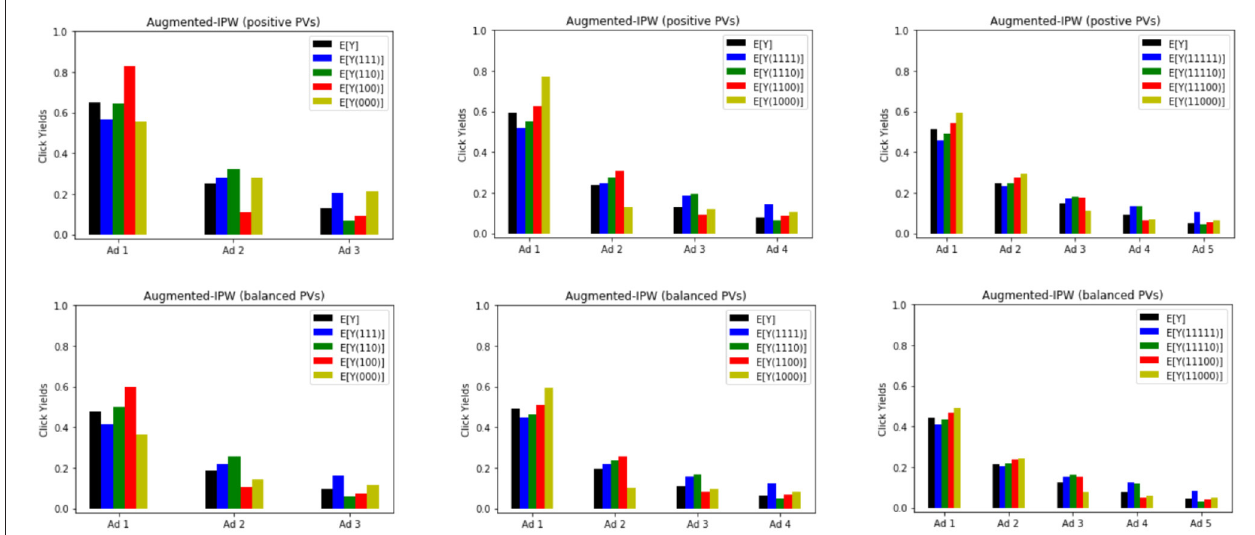
FIGURE 2 | Estimates of E [ Y i ( a )] for all possible allocations using AIPW on pageviews with 3,4,5 impressed ads.